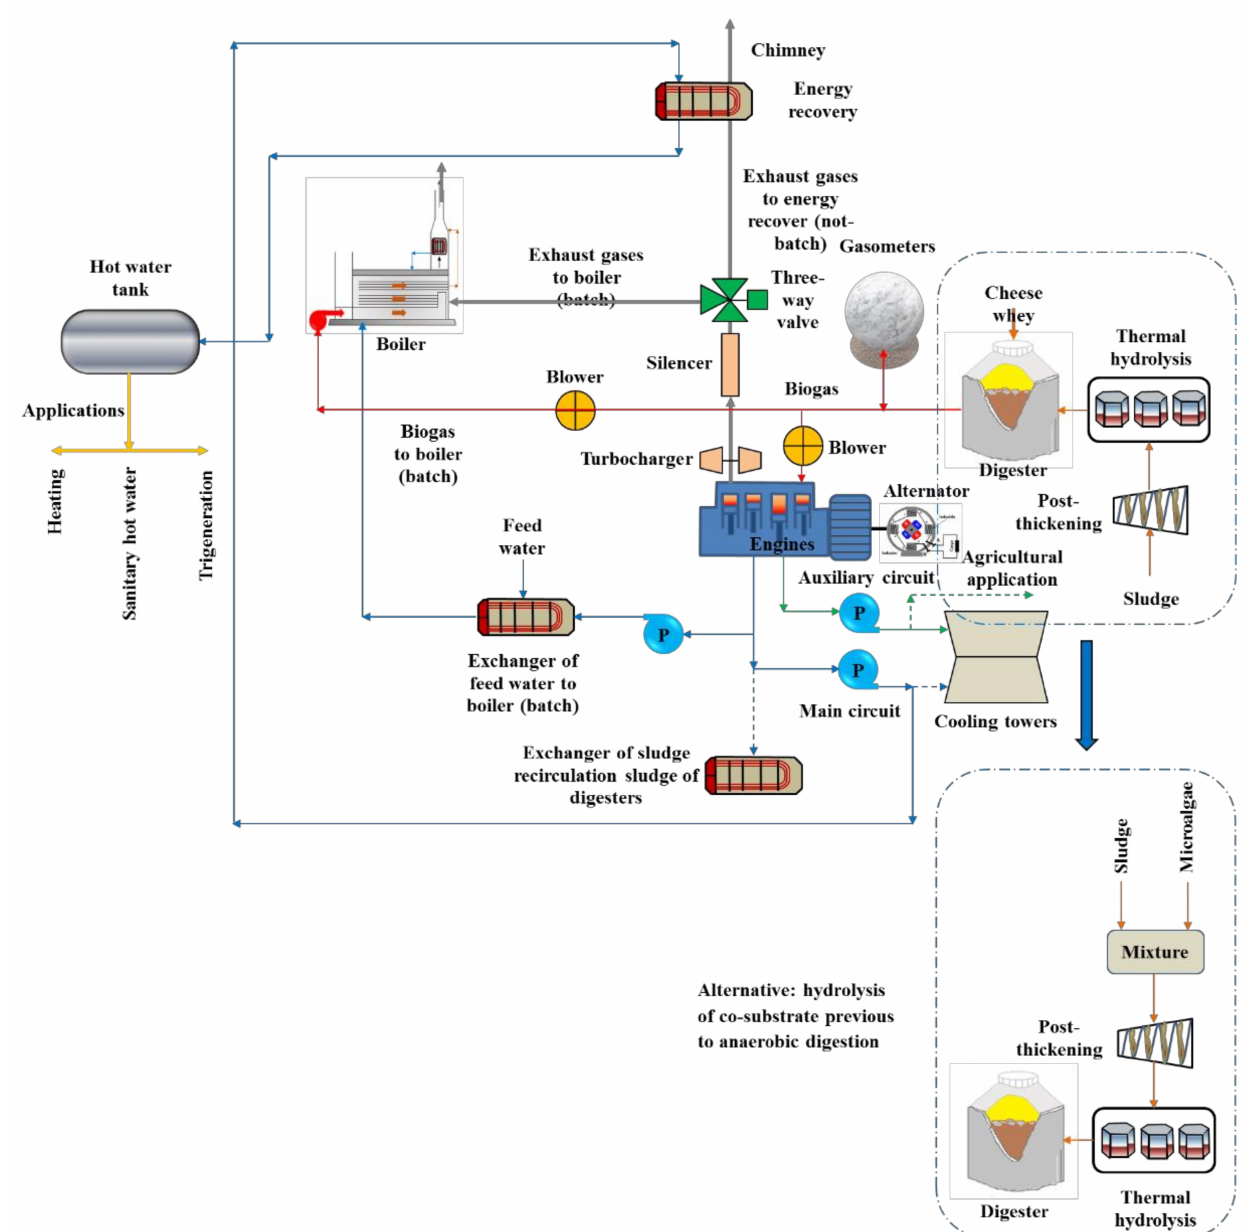
Figure 8. Proposed scheme for cheese whey co-digestion and hydrolyzed sludge. As alternative to this process is represented in the case where a thermally pre-treated co-substrate is introduced into the digestion line. The scheme also represents biogas valorization, the recovery energy system, and thermal